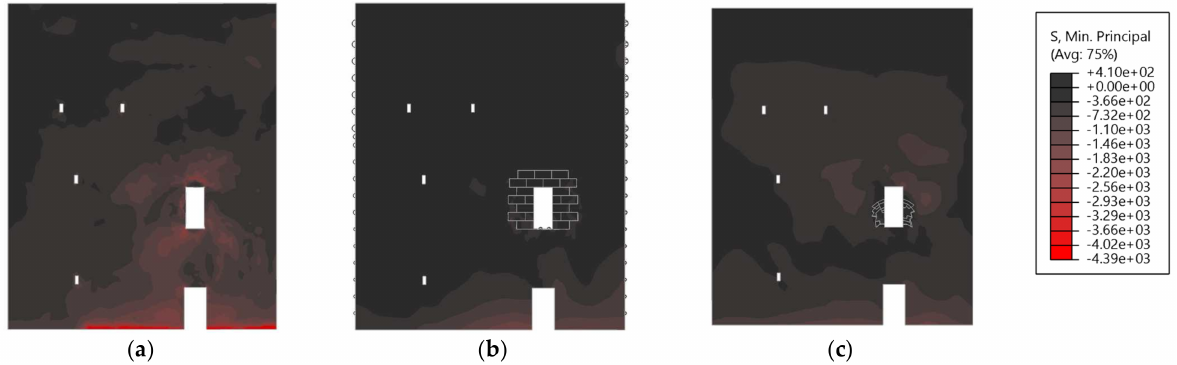
Figure 12. Compressive stresses on the south façade: ( a ) whole building model; ( b ) simplified contact model; ( c ) simplified continuum